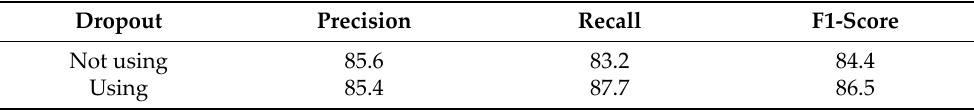
Table 8. Experimental results with and without dropout.